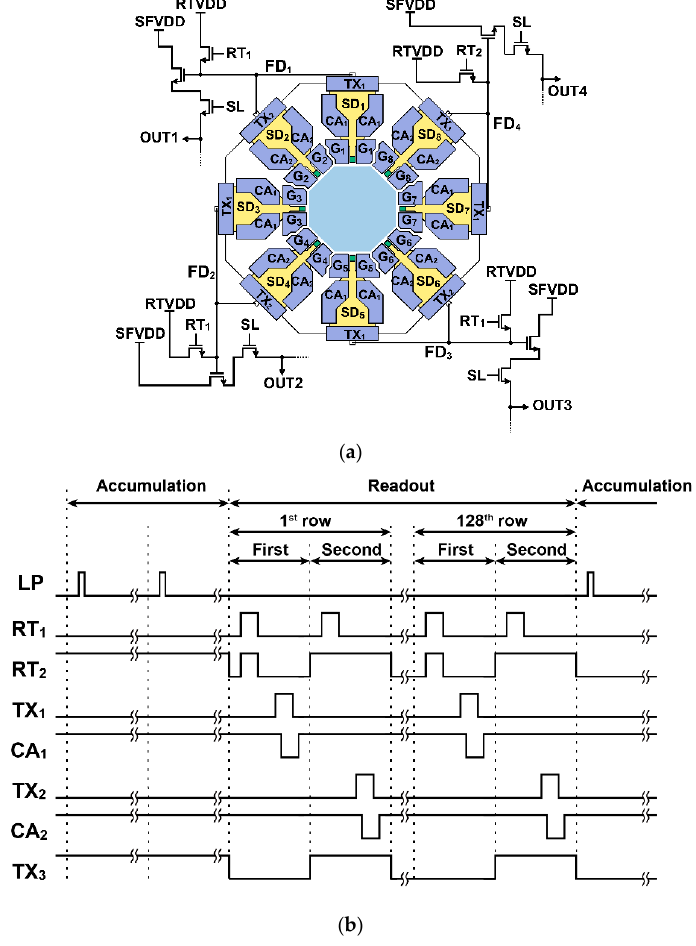
Figure 6. Pixel circuits and readout operation: ( a ) equivalent circuit and ( b ) timing diagram for accumulating and reading photo signals. accumulating and reading photo